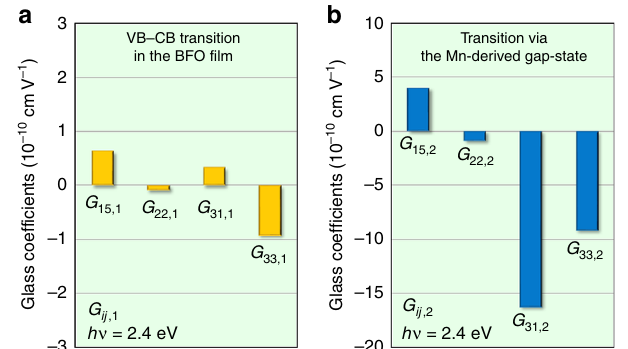
Fig. 6 Glass coef fi cients of G ij ,1 and G ij ,2 at h ν = 2.4 eV. a G ij ,1 represents the photogenerated strength arising from the one-photon optical transition of the VB to the CB in the BFO fi lm, while b G ij ,2 re fl ects what is attributed to the charge transfer transition via the Mn-3 d -derived gap (2 e )